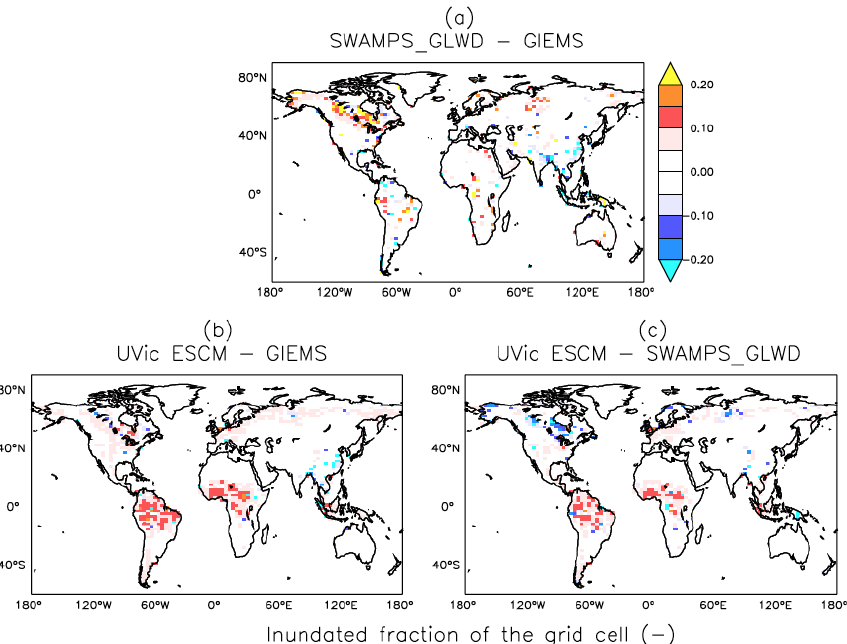
Figure 6. Differences in global wetland extents (inundated fractions of grid cells) between two datasets (GIEMS and SWAMPS-GLWD) and the UVic ESCM over the 2000-02007 period: (a) SWAMPS-GLWD – GIEMS, (b) UVic ESCM – GIEMS, and (c) UVic ESCM – SWAMPS-GLWD. The comparison period corresponds to the overlap period for the two